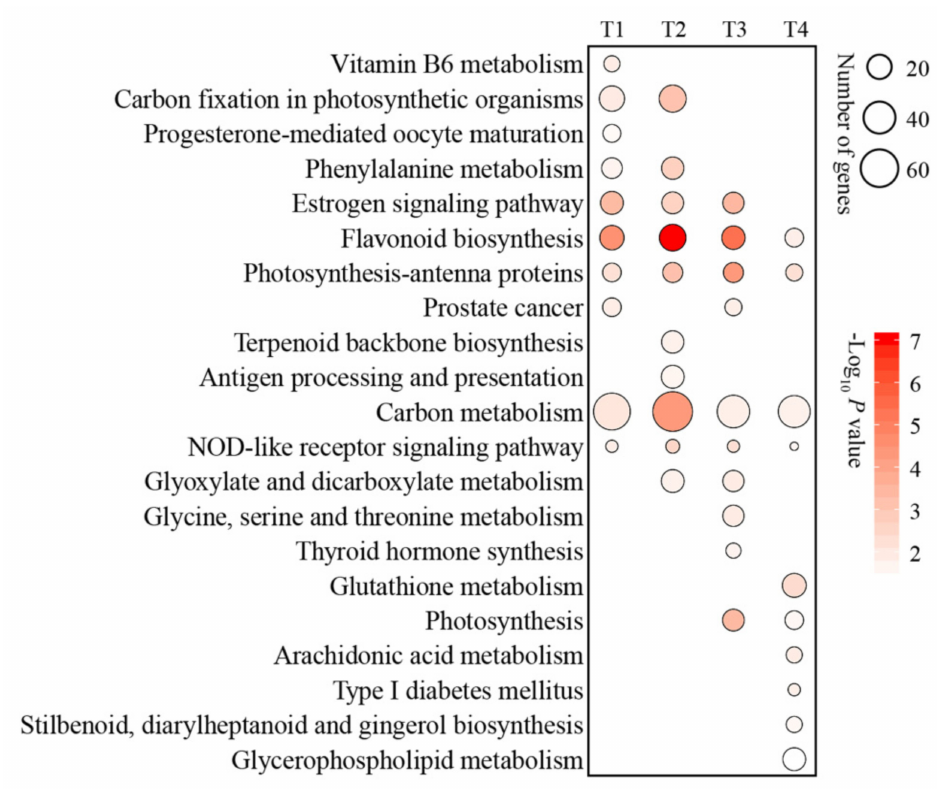
Figure 4. Kyoto Encyclopedia of Genes and Genomes (KEGG) enrichment analysis of differentially expressed genes (DEGs) in apple in the comparisons of 35 ◦ C vs. 25 ◦ C at T1, T2, T3, and T4. T1, T2, T3, and T4 represent apples after 3, 6, 9, and 12 days of 25 ◦ C and 35 ◦ C treatment,